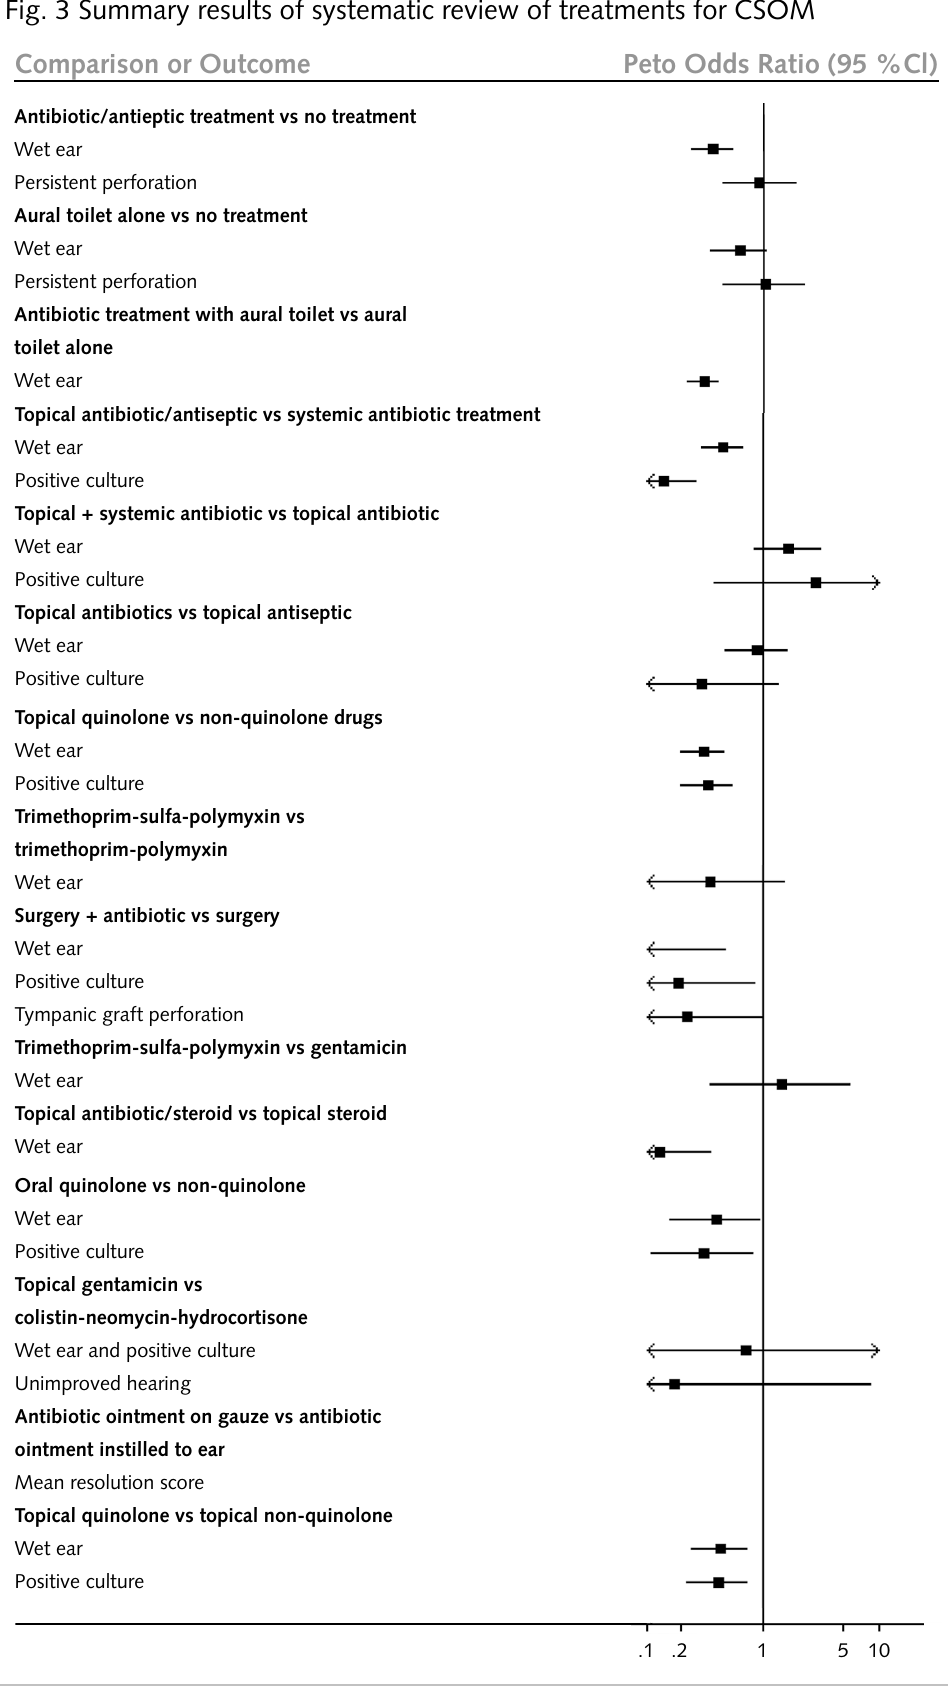
Fig. 3 Summary results of systematic review of treatments for CSOM Comparison or Outcome Peto Odds Ratio (95